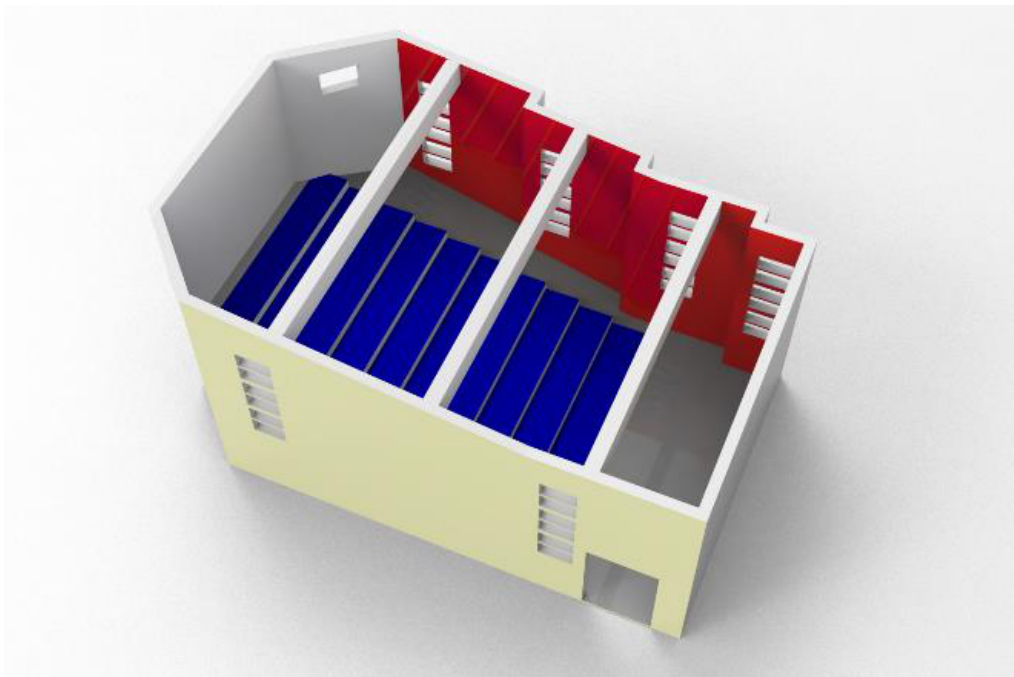
Figure 4. Geometry isometric view